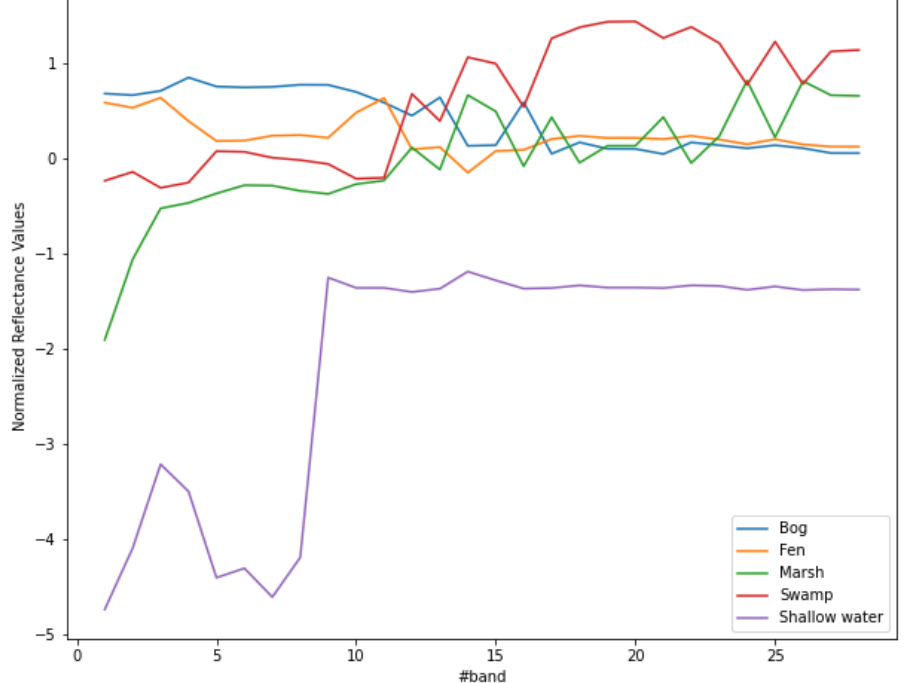
Figure 9. Overview of normalized band intensities of several samples of bog, fen, marsh, swamp, and shallow water wetlands for Sentinel-1 and Sentinel-2 data in the pilot site of the Avalon.